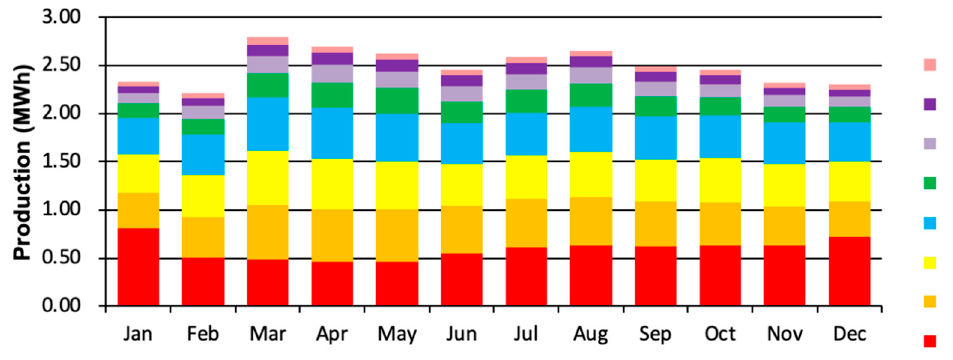
Figure 19. Monthly electricity production of the OSC at 57.7 kWh/day.